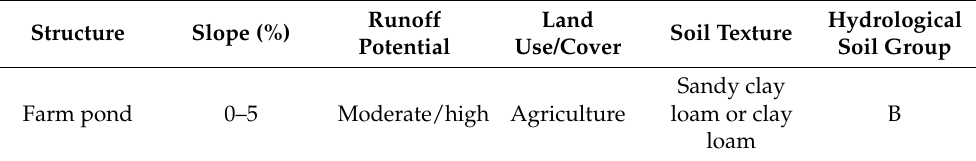
Runoff Land Hydrological Soil Texture Potential Use/Cover Soil Group Sandy